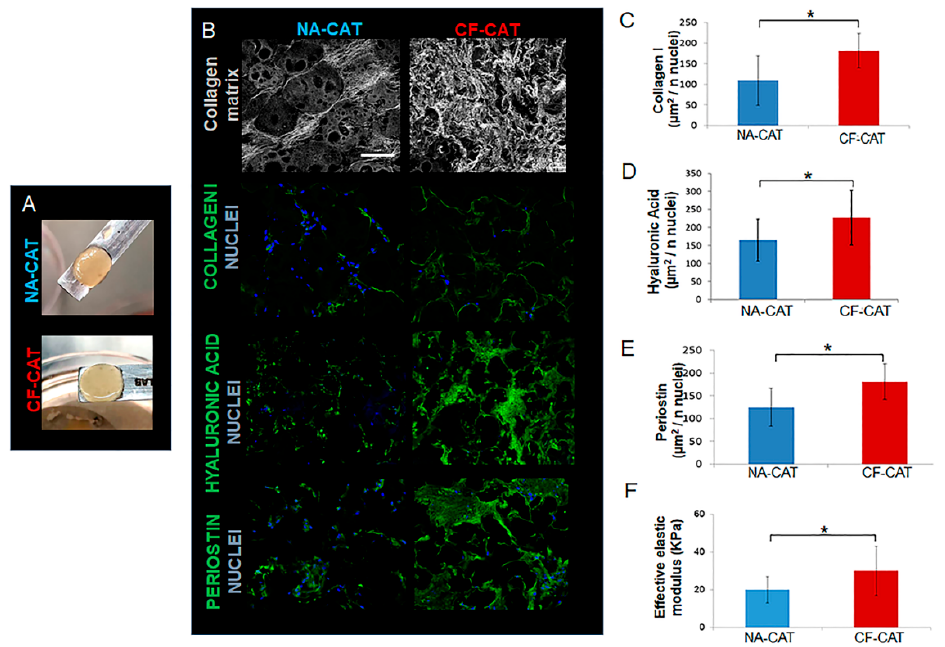
Figure 4. CAT morphological analysis. ( A ) Macroscopic image of a representative normal and cystic fibrosis connective airway tissue (NA-CAT and CF-CAT); ( B ) Second harmonic generation (SHG) images of collagen fibers in gray and immunofluorescence showing the nuclei of the cells in blue marked by DAPI and in green the signal of Collagen Type I / Hyaluronic Acid and Periostin; scale bar 100 µ m; ( C ) Diagram of the quantity of collagen ( µ m 2 ) type I per cell (nuclei) NA-CAT (blue) and CF-CAT (red); ( D ) Diagram of the quantity of Hyaluronic Acid ( µ m 2 ) type I per cell (nuclei) NA-CAT(blue) and CF-CAT (red); ( E ) Diagram of the quantity of Periostin ( µ m 2 ) type I per cell (nuclei) NA-CAT(blue) and CF-CAT(red); ( F ) Diagram of the e ff ective elastic modulus of the NA-CAT(blue) and CF-CAT(red). In all the diagrams data are showed as Mean ± Standard Deviation * p value <0.05.